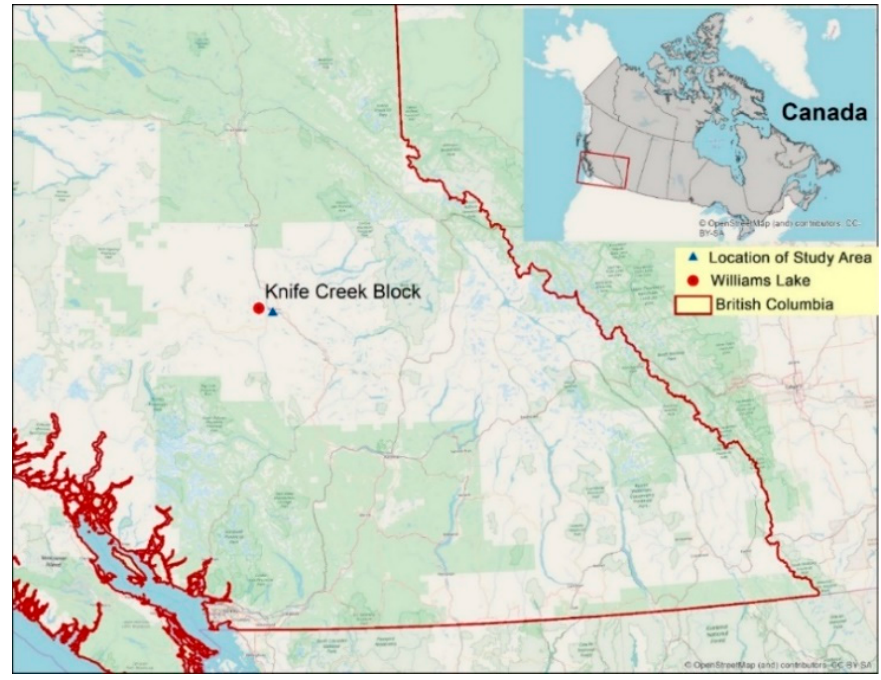
Figure 1. Location of the Knife Creek Block near Williams Lake in British Columbia, Canada. During the summers of 1989 and 1990, three blocks (B, C, and D), of approximately 40 hectares each, were selected for this experiment. Block B is quite dry, Block C is more mesic, and Block D is the moistest of the sites and is transitional to the Sub-Boreal Spruce (SBS) BEC zone. The stands were logged during the 1950s and 1960s to a diameter limit of approximately 25.4 cm, although a few of the larger trees were not harvested. Block B was dominated by interior Douglas-fir (>80% by basal area), with the remaining basal area consisting of lodgepole pine and a small percentage (<0.5%) of trembling aspen ( Populus tremuloides Michx). Block C was also dominated by Douglas-fir (>60% basal area). Lodgepole pine varied among the plots (0%–26.5% basal area) and there was a small interior